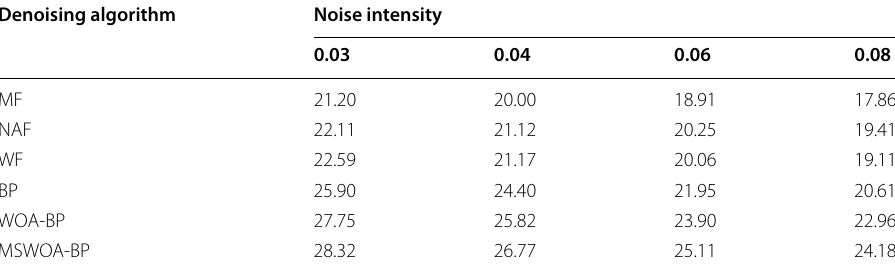
Table 5 PSNR of image denoising Denoising